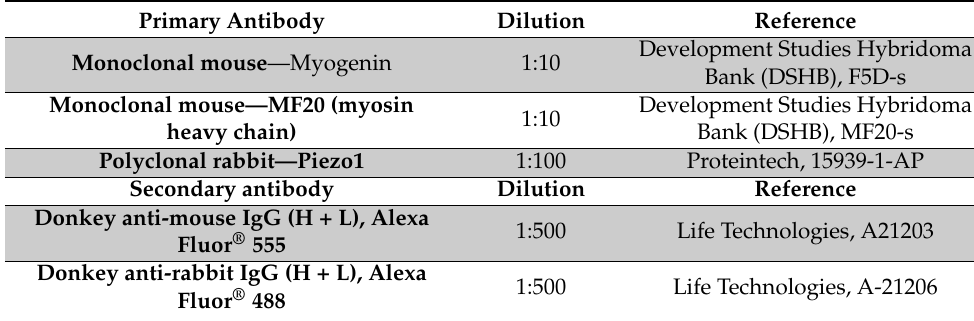
Table 3. Primary and Secondary antibodies